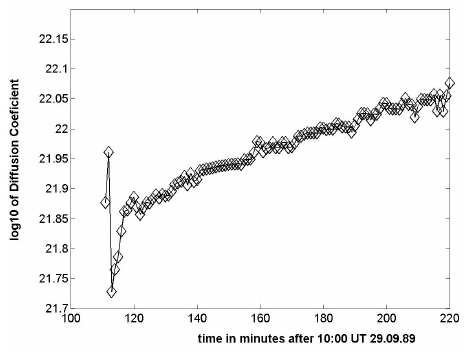
Fig. 3. Diffusion coefficient K 1 (R) near the Earth’s orbit (in units 10 23 cm 2 /s − 1 ) depending of time (in minutes after 10:00:UT on 29 September